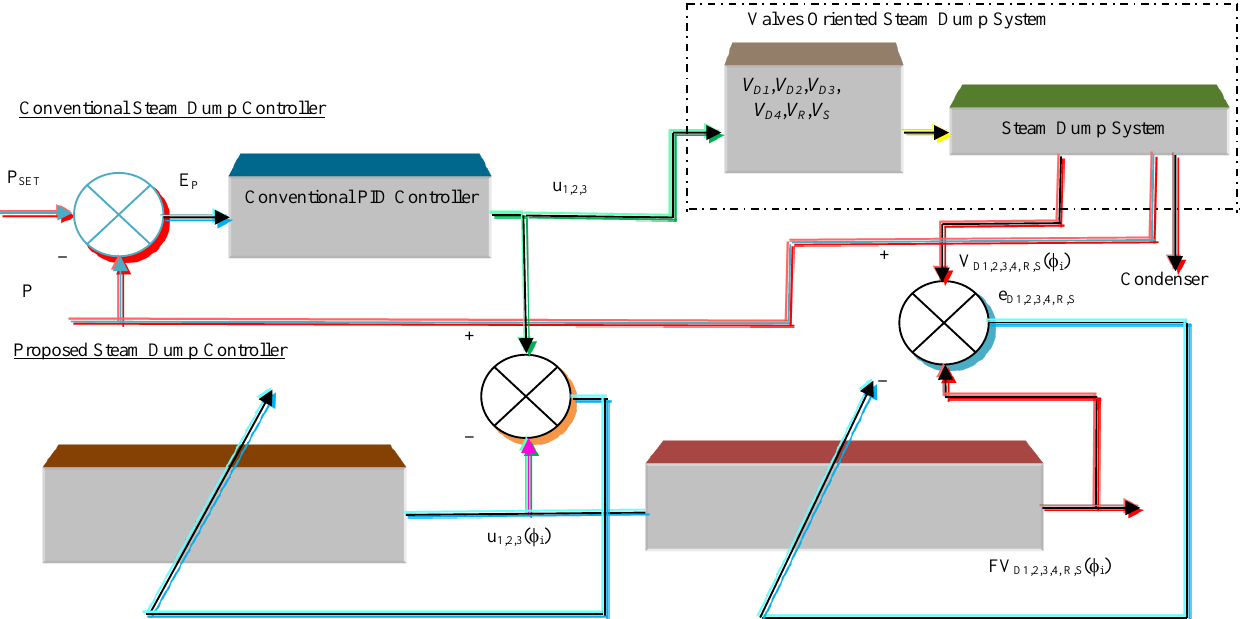
Fig. 4. Closed loop framework for fractional order steam dump control system design